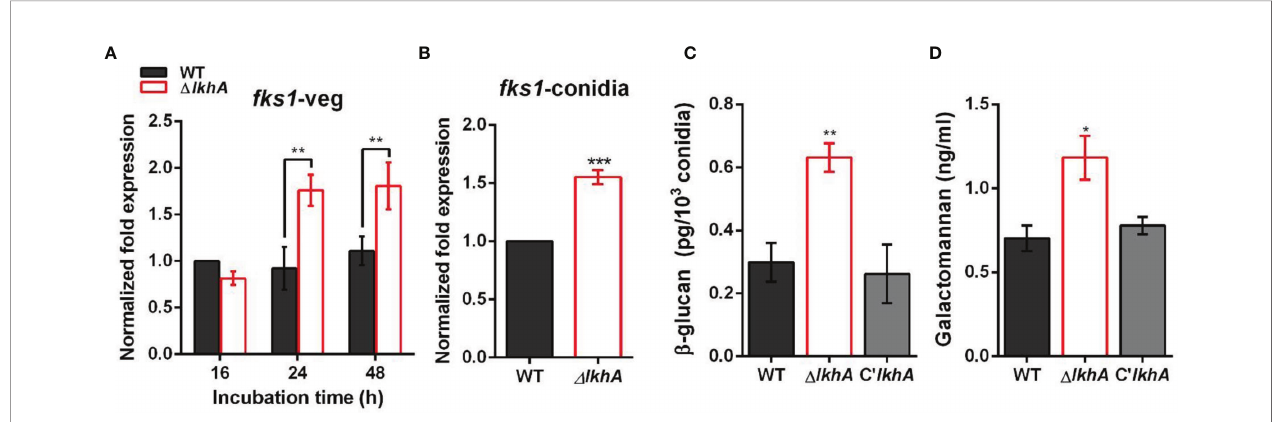
FIGURE 6 | Roleof A fl khA inbiosynthesisof conidialcell walls. Expression level of b -1,3-glucan synthase fks1 in vegetative cells (A) and conidia (B) . Spores were inoculated in MMliquid culture and incubated for the indicated number of hrs. TotalRNA was extracted and RT-qPCR analysiswas performed using 18S rRNA gene as an internal control.**P < 0.01, ***P < 0.001. (C) Amount of b -glucan (pg) per 10 3 conidia inWT and D A fl khA strains (n= 4).**P < 0.01 (D) Concentration (ng/mL) of GM.Conidia was inoculatedin modi fi edBrian medium and cultured at 37°C for 24 hrs. Extracellular GM content in the culture supernatantwas assayedby ELISA (n = 4).*P <